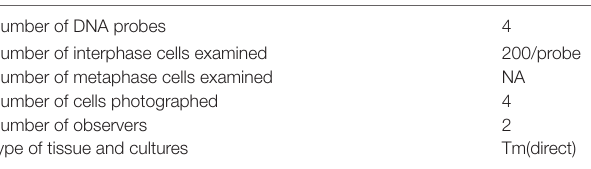
taBLe 1 | Fluorescence in situ hybridization analysis summary. Number of DNA